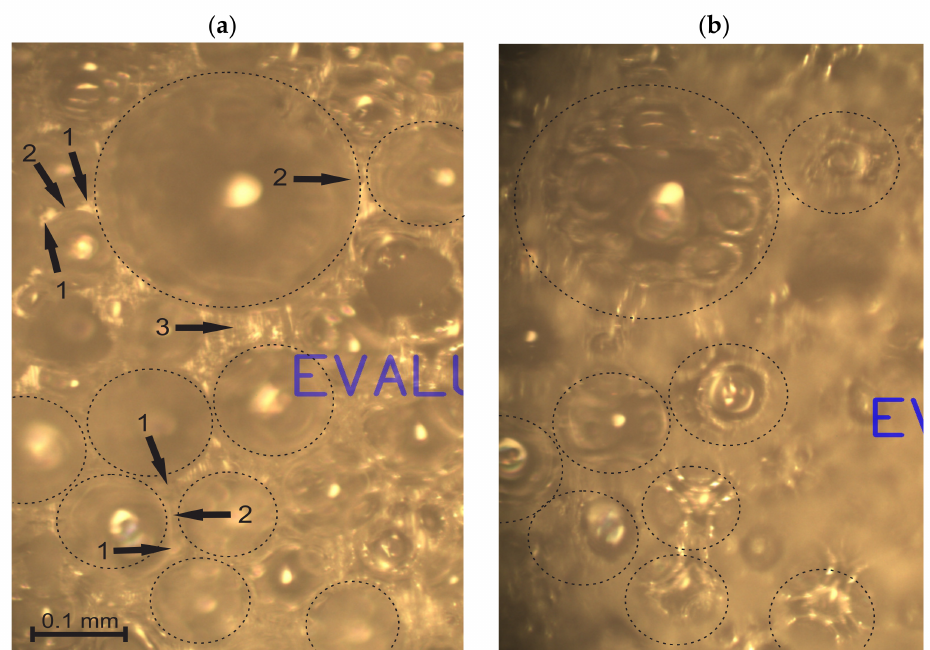
Figure 3. One and the same location of neat, medium-density PU foams, ρ = 211 kg/m 3 (P1 = 16.5%): ( a ) cutting surface image with struts (1), walls (2), and un-foamed volumes (3); and ( b ) through-cutting surface image. Image plane X 1 =